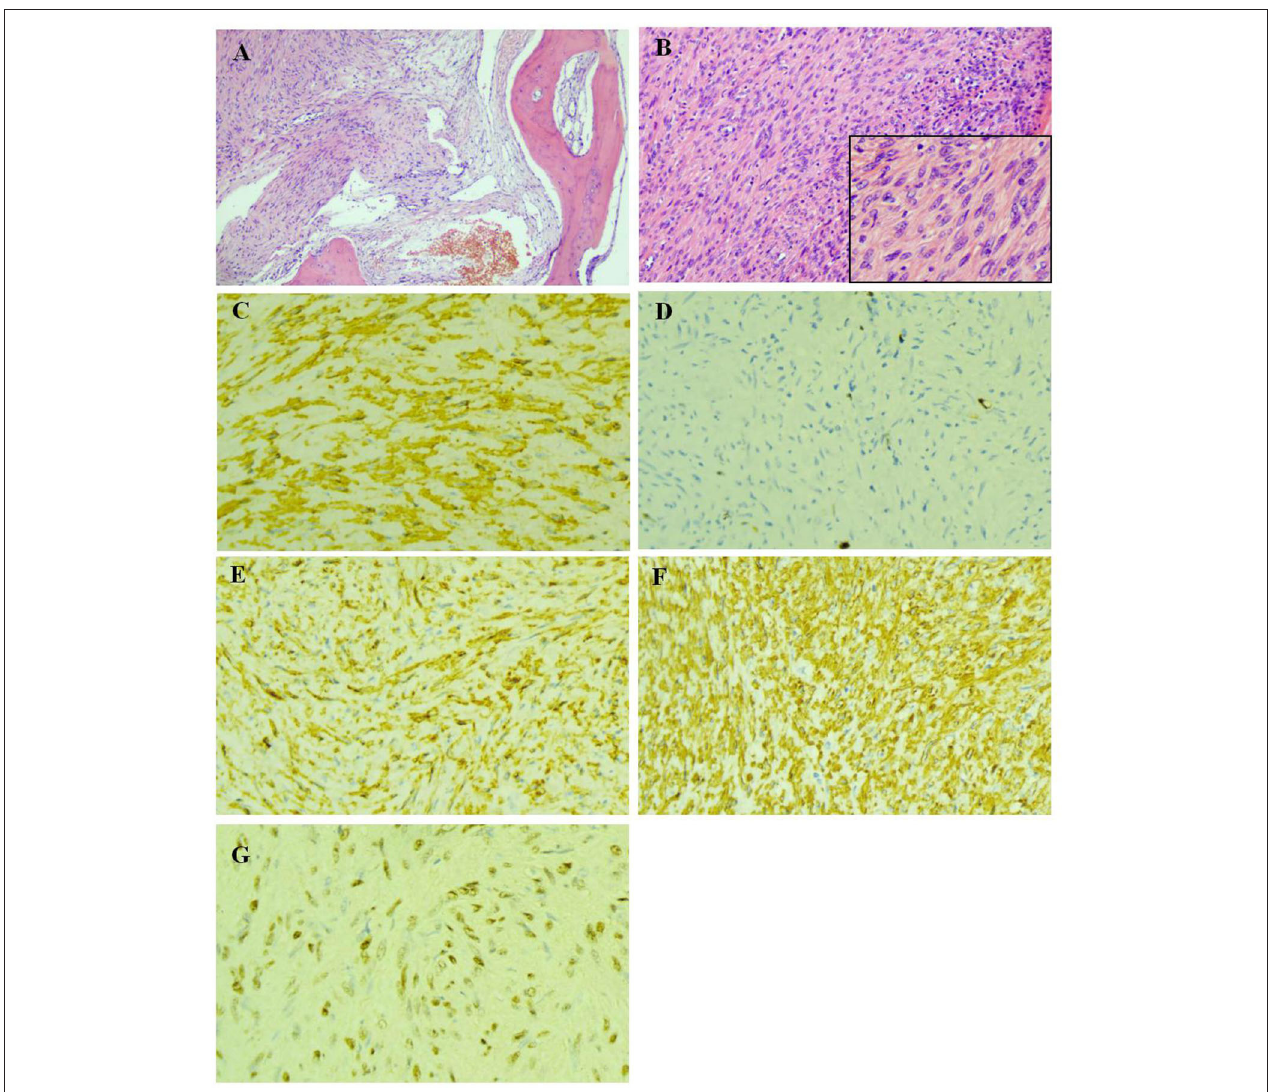
FIGURE 3 | Pathological examination of the biopsy of lesion tissues of the L2 vertebral body. (A) The bone tissue were invaded by tumor cells (HE × 100). (B) The tumor cells was spindle-shaped, with abundant cytoplasm, red stain and mild atypia, while no evident nuclear fission was observed (HE × 200). (C) The actin were expressed in the cytoplasm of tumor cells (IHC × 400). (D) The highest ki-67 positive index was 6% (IHC × 400). (E) The h-Caldesmon were expressed diffusely in the cytoplasm of tumor cells (IHC × 400). (F) SMA were expressed diffusely in the cytoplasm of tumor cells (IHC × 400). (G) Epstein-Barr virus encoded RNA situ hybridization showed diffusely positive (EBER ×